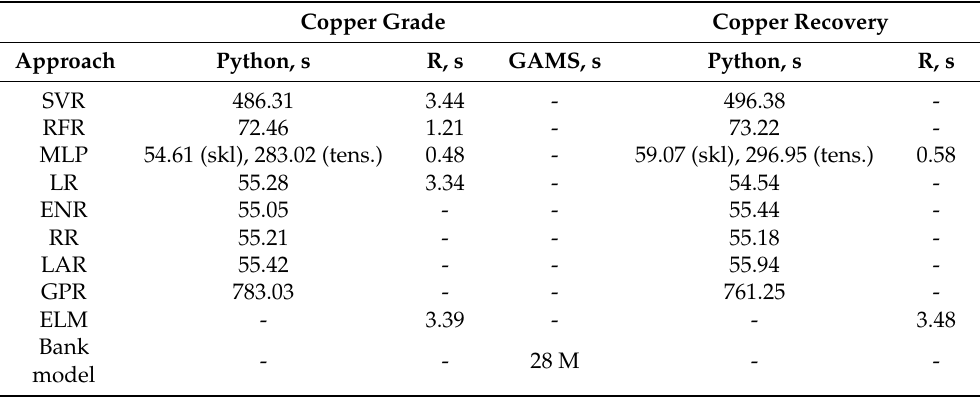
Figure 9. Total sensitivity indices obtained via the Sobol–Jansen method and SMs, copper recovery. Table 5. Execution time for the Sobol–Jansen method using SMs, cell